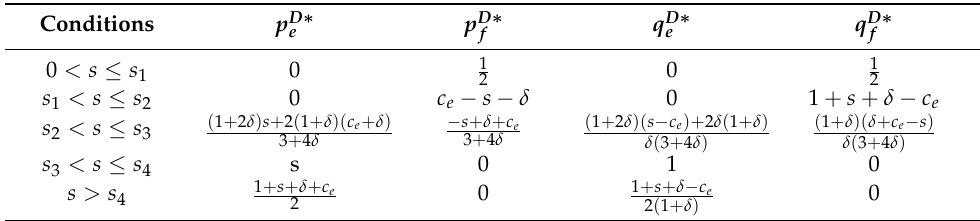
Table 6. Equilibrium price and quantity under the demand subsidy scenario.